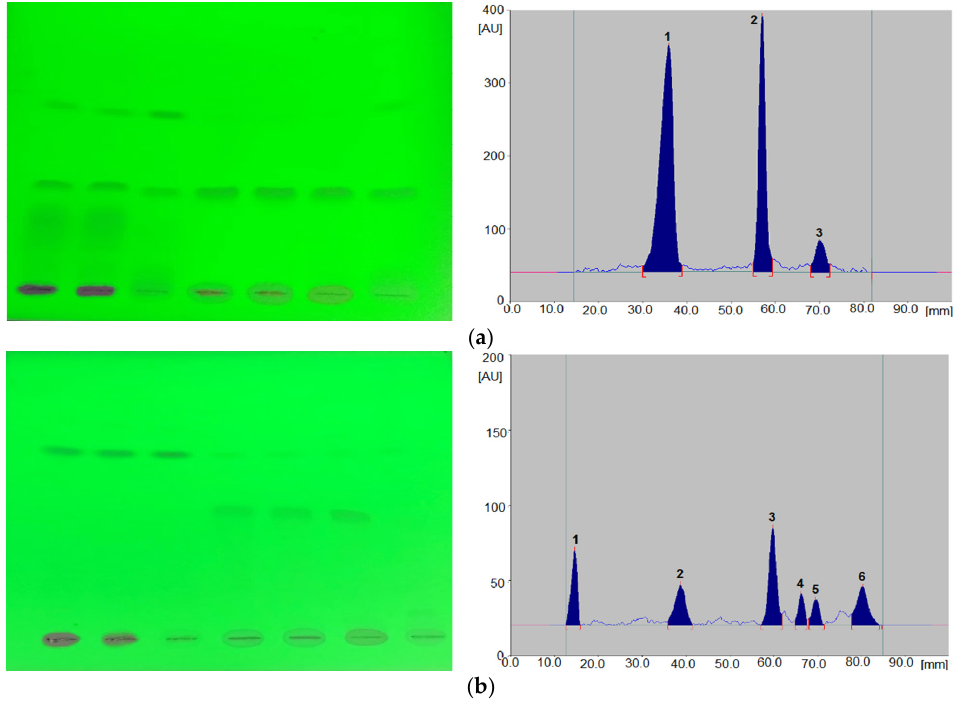
Figure 5. An example of chromatograms and densitograms for solutions incubated: ( a ; 1-grapiprant, 2,3-degradation products) 96 h at 70 ◦ C and ( b ; 2-grapiprant, 1,3,4,5,6-degradation products) 696 h at room